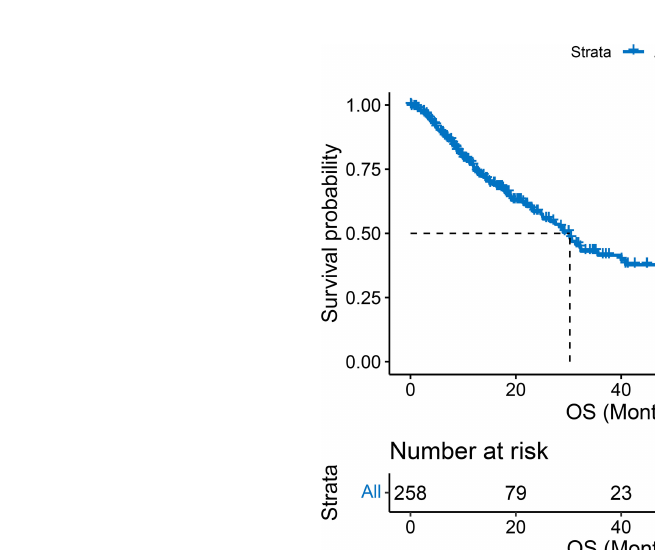
FIGURE 2 Kaplan-Meier curves of overall survival (A) in whole population.